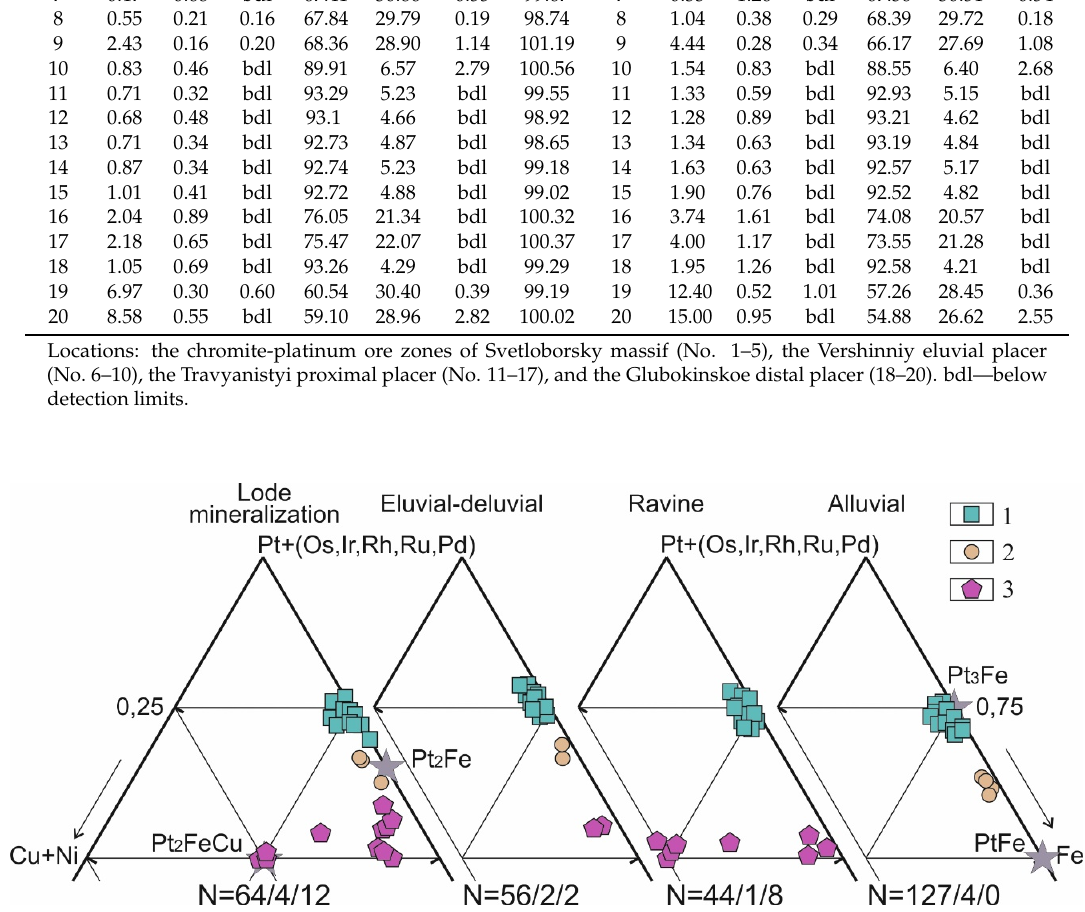
Figure 7. Composition (at. %) of isoferroplatinum (1), ferroan platinum (2) and tetraferroplatinum- tulameenite (3) from placers associated with the Svetloborsky massif and lode chromite-platinum ore zones. N—number of isoferroplatinum/ferroan platinum/tetraferroplatinum-tulameenite. The grey Pentagrams are stoichiometric formulae.